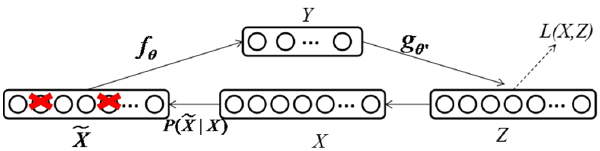
Figure 1. Encoding and decoding process of denoising autoencoder.